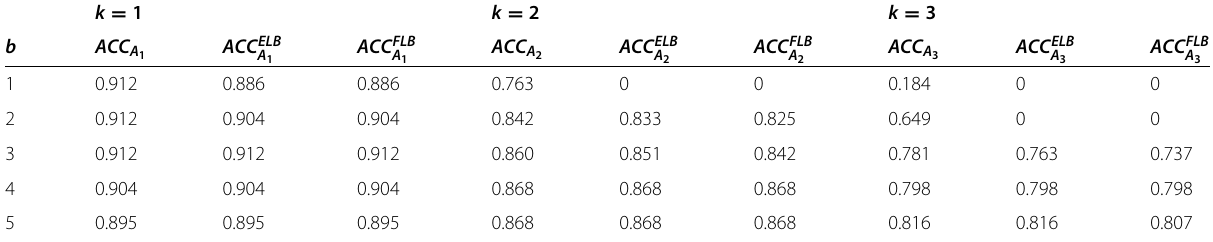
Table 7 Accuracy lower bound analysis on B REAST _C ANCER . f-FPF with | T | ≈ 300 and 8 leaves k = 1